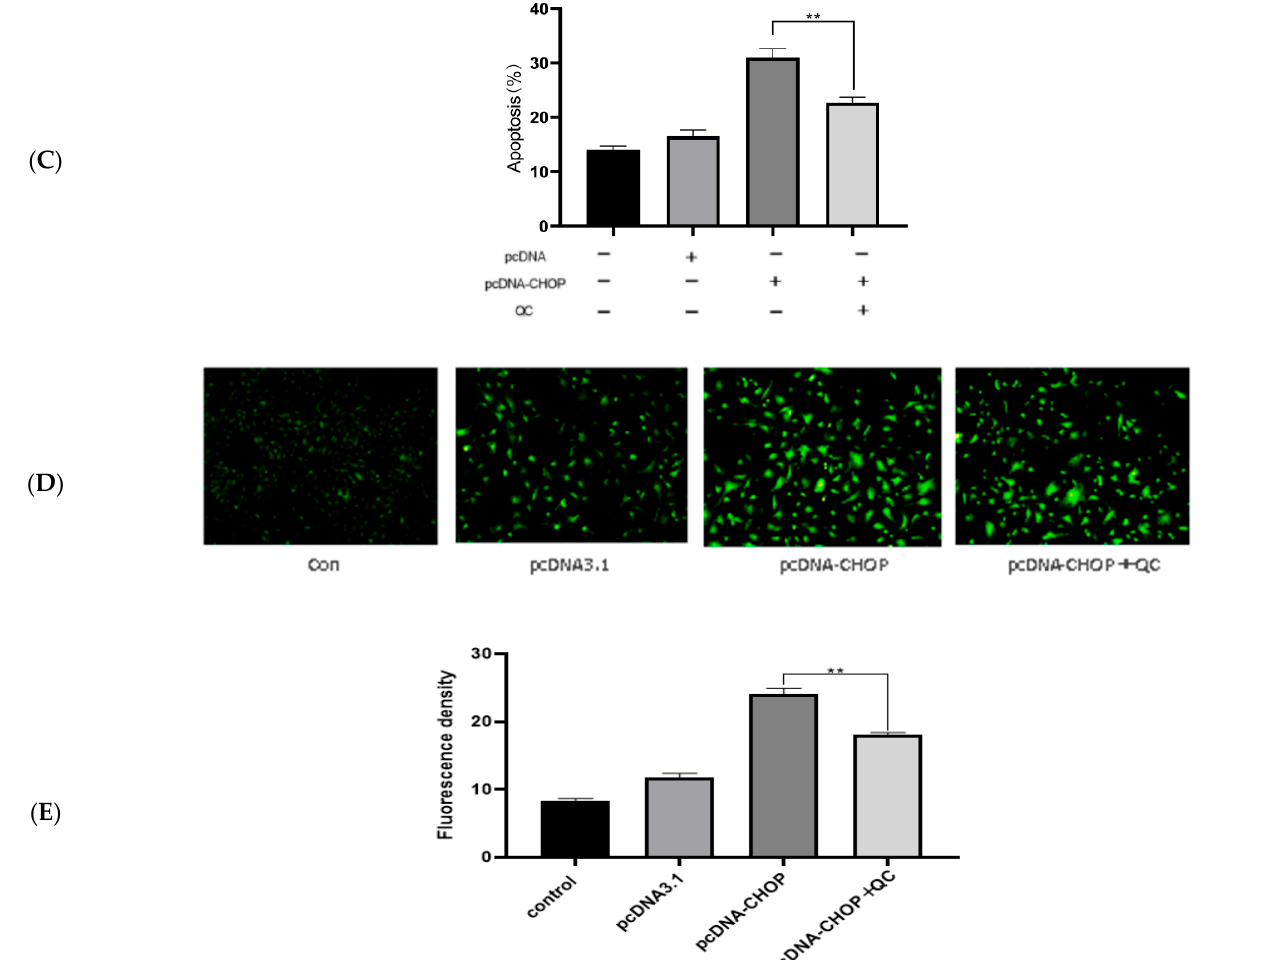
Figure 5. Effects of activation of Chop gene. control: blank control group; pcDNA3.1: transfected with pcDNA3.1 plasmid group; pcDNA3.1-CHOP: transfected with Chop overexpression plasmid group; pcDNA3.1-CHOP + QC: pretreated with QC, then transfected with Chop overexpression plasmid group: ( A ) The expression level of the Chop gene after transfection of pcDNA3.1-CHOP plasmid. ( B ) After transfection of pcDNA-CHOP plasmid, cell apoptosis was evaluated by flow cytometry. ( C ) Statistics of apoptotic cells. ( D ) After transfection of pcDNA-CHOP plasmid, the intensity of ROS in cells was detected by fluorescence microscope. The higher the fluorescence intensity, the higher the intracellular ROS content. ( E ) Fluorescence density statistics. The asterisks refer to the level of significance (** p < 0.01). Values are presented as means ± SD for 3 biological replicates.